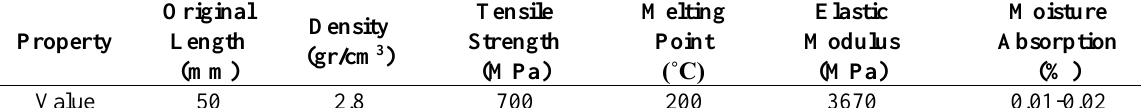
Table 3. Properties of the fibers used in this research